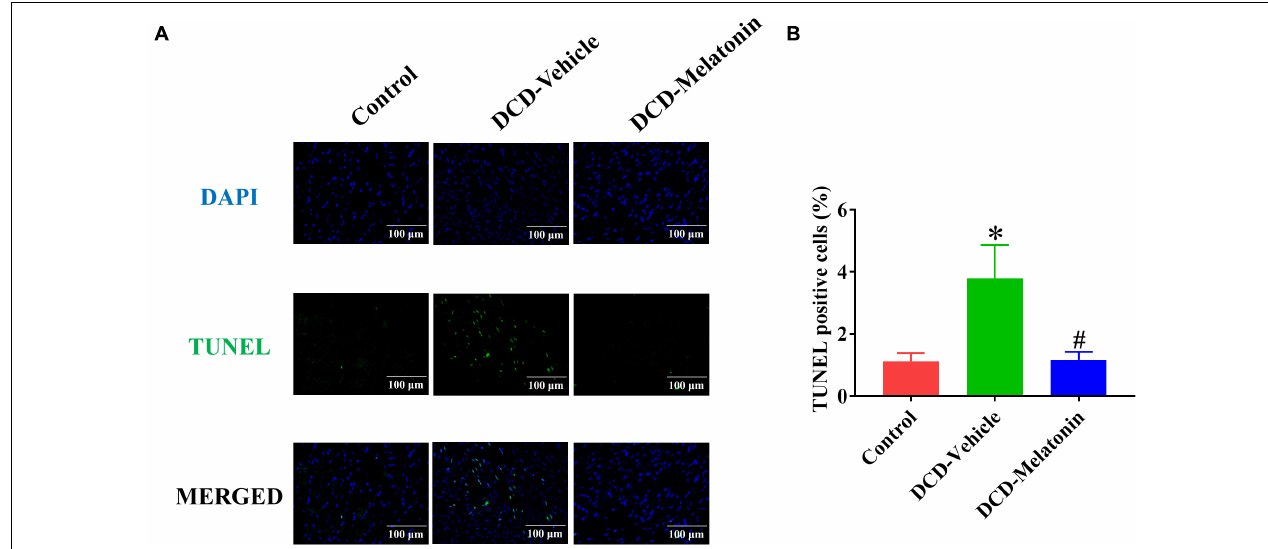
FIGURE 6 | Apoptosis evaluation of the DCD heart submitted to EVHP. (A) Representative photomicrographs of myocardial tissue stained with DAPI (blue), nuclei with fragmented DNA shown by TUNEL staining, and merged image (magnification of 40; scale length: 100 µ m); and (B) quantification of TUNEL-positive cells (as a percentage). Data represent mean ± standard error of the mean. n = 8 for each group. DAPI, 4 (cid:48) ,6-diamino-2-phenylindole (DAPI, blue); DCD, donation after circulatory death; EVHP, ex vivo heart perfusion; TUNEL, terminal deoxynucleotidyl transferase-mediated dUTP nick end-labeling. ∗ p < 0.05 vs. control; # p < 0.05 vs.